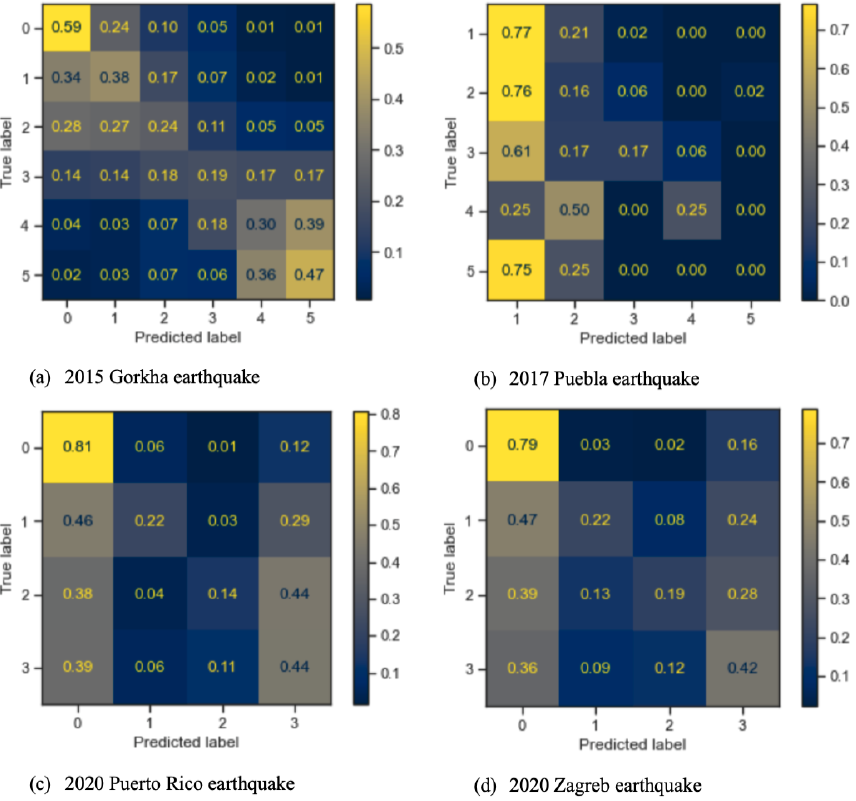
Figure 6. Normalized confusion matrices for the test set for multi-class damage classification. The labels refer to progressive damage grades, as described in Tables 2, 4, 6, and 8.